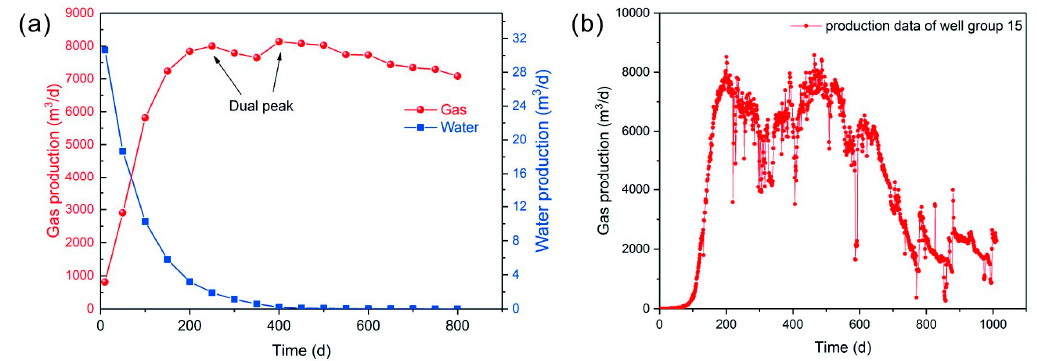
Figure 5. Production profile characteristics, ( a ) numeric simulation results of the water and gas production rates, ( b ) gas production profile for the well group 15 in Fukang Mining Area.